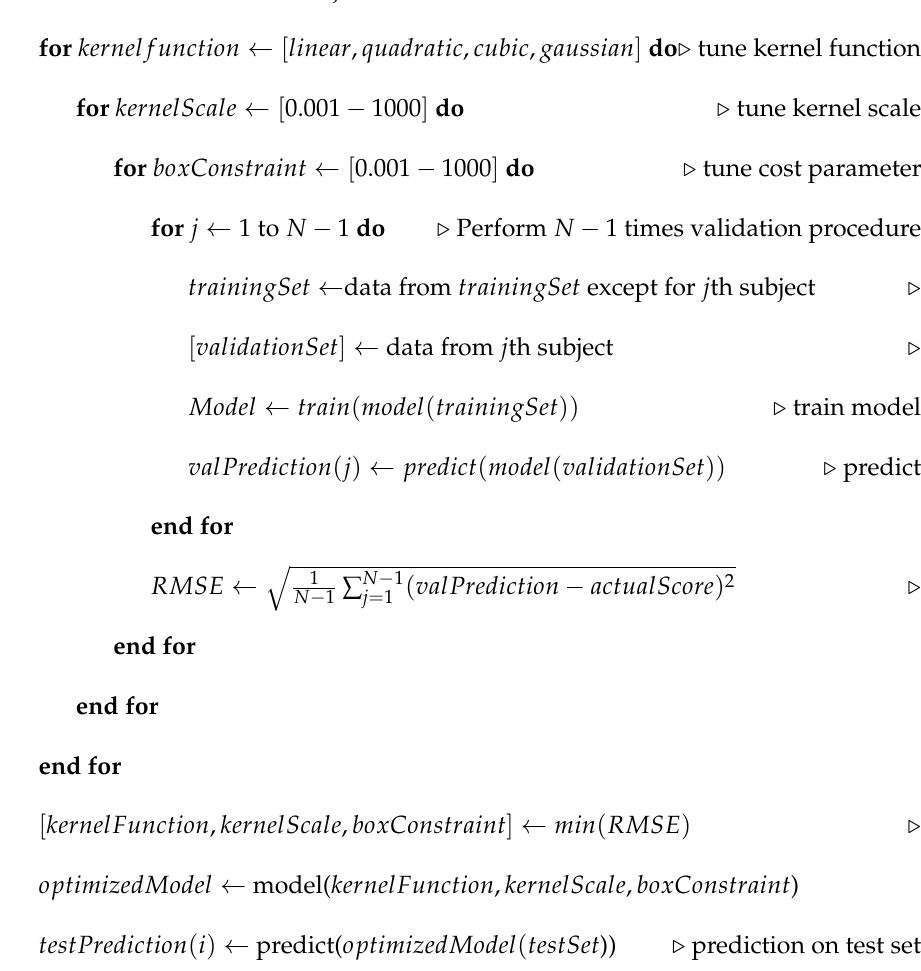
Algorithm 1 Algorithm for model optimization, validation and test performance